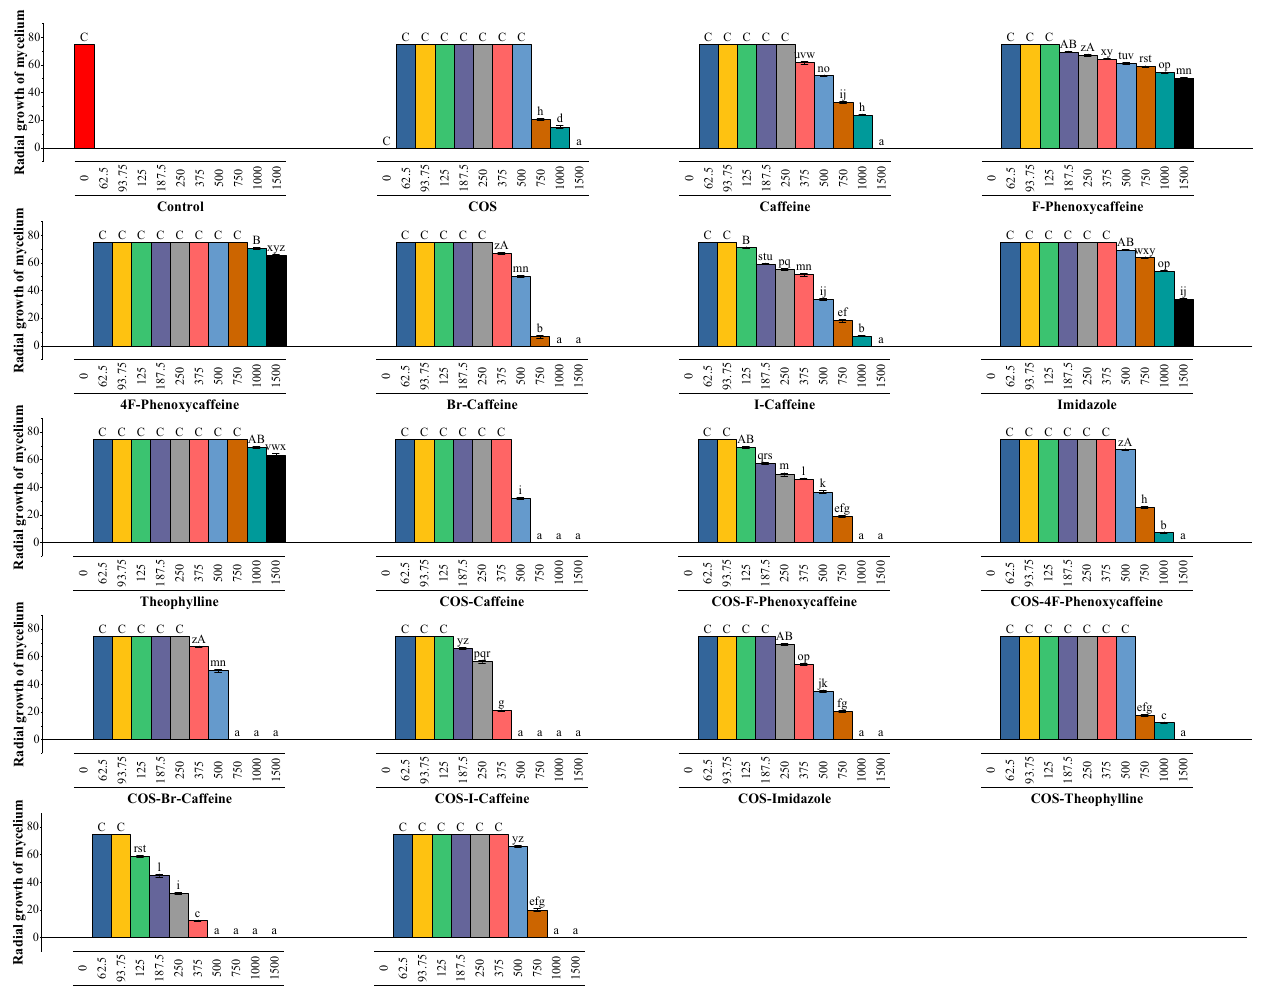
Figure 4. Mycelial growth inhibition of D. seriata by caffeine, its derivatives, imidazole, and theo- phylline, their respective COS–conjugated complexes, and some selected ternary combinations with imidazole at different concentrations (ranging from 62.5 to 1500 µg mL − 1 ). Error bars represent standard deviation. Treatment–concentration combinations accompanied by the same letters are not significantly different at p < 0.05 according to Tukey’s HSD test after a two-way ANOVA (Tukey’s HSD lettered grouping follows the sequence a–z, A–C, where ‘a’ indicates the group of treatment– concentration combinations with the highest efficacy and ‘C’ the group of least effective treatment– concentration combinations).